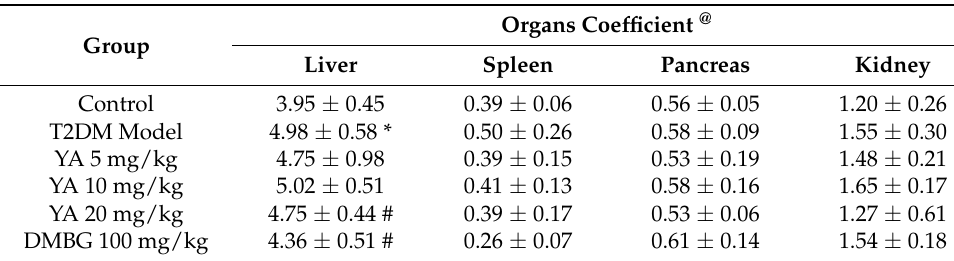
Table 1. Weights of livers, spleens, pancreases, and kidneys in different groups. (# p < 0.05 vs. control; * p < 0.05 vs. T2DM model).